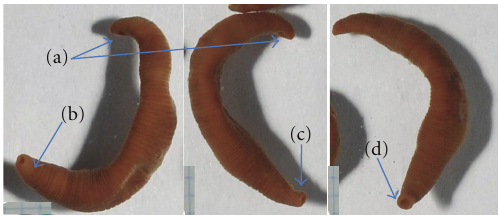
Figure 5: Morphology of the A. peledina from the Chechuj River: (a) anterior sucker, (b) posterior sucker; (c) elongated posterior end of the body; (d) posterior sucker in a normal state.